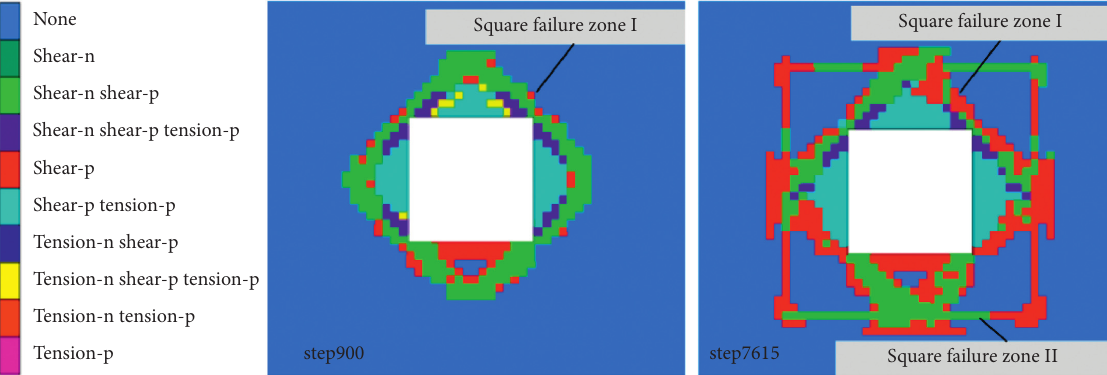
Figure 4: Evolution of plastic zone of the surrounding rock.